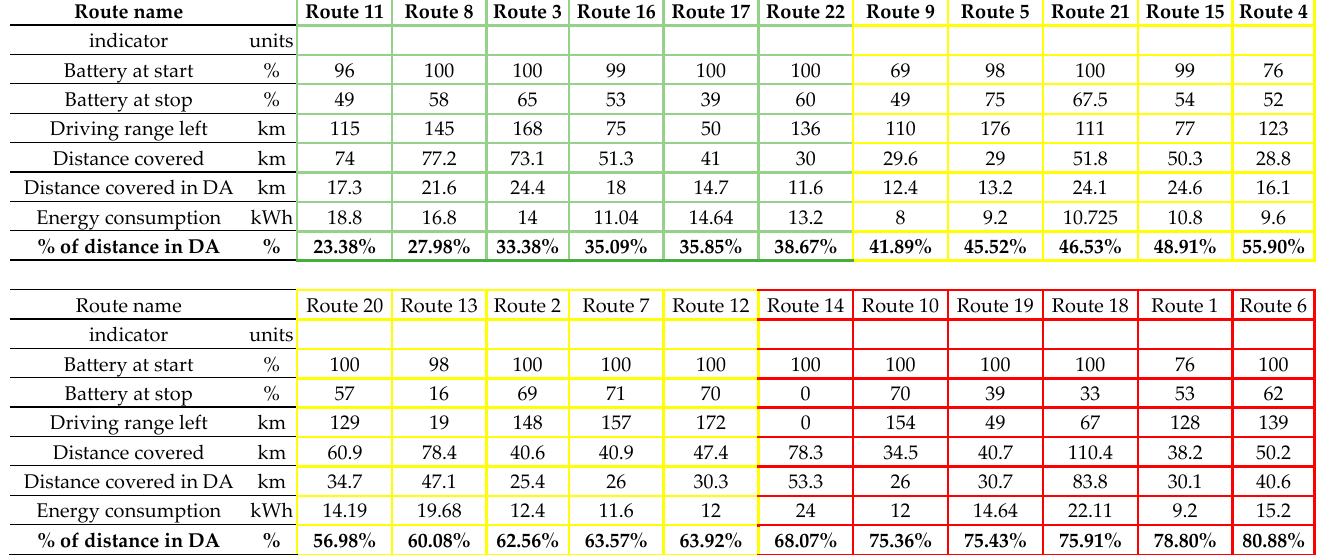
Table 1. Classes of routes due to the structure of their sections.